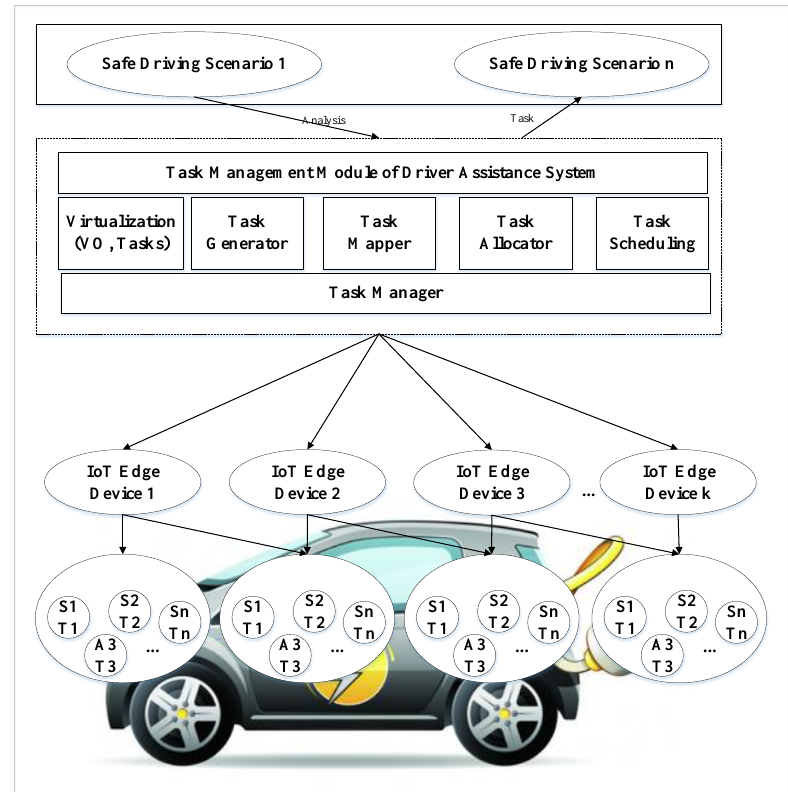
Figure 1. General system model of task modeling in driver-assistance